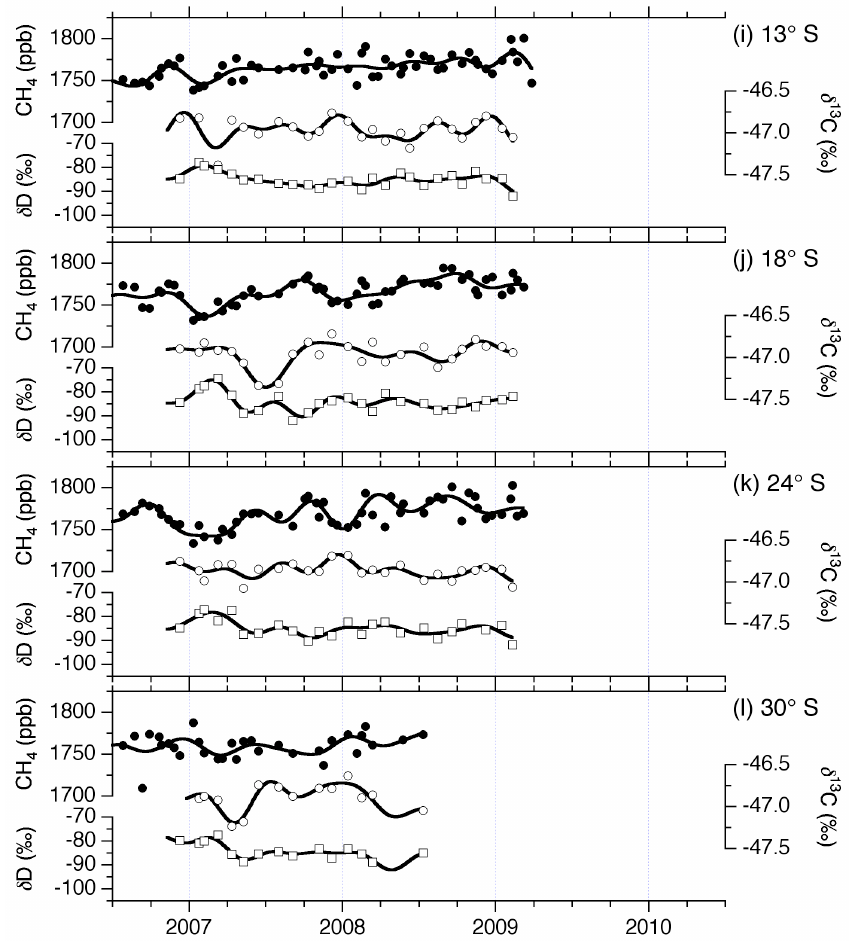
Fig. 2. Same as Fig. 2a–d, but for (i) 13 ◦ S, (j) 18 ◦ S, (k) 24 ◦ S and (l) 30 ◦ S beween Australia and Japan. Note that the axis ranges of the CH 4 mixing ratio are different from Fig.